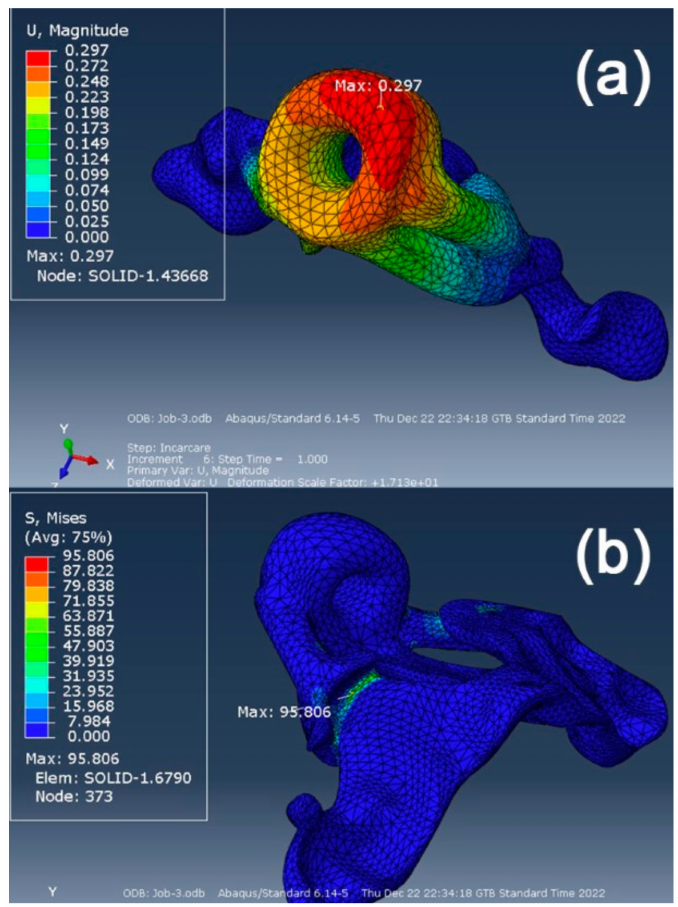
Figure 5. ( a ) maximum displacement and ( b ) equivalent stress